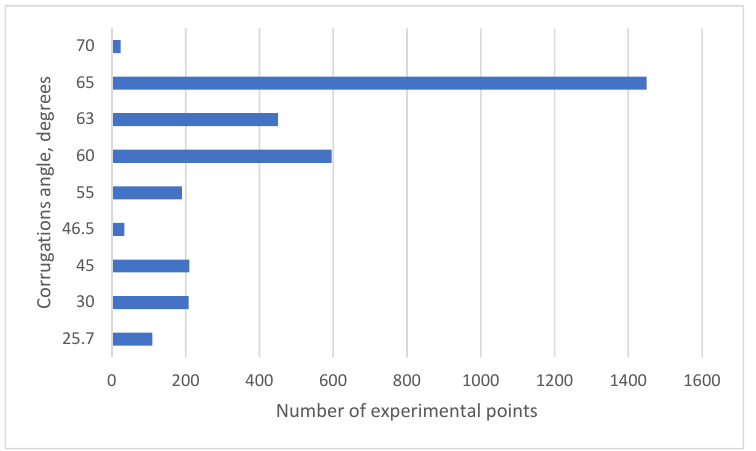
Figure 3. The number of experimental points data received in studies of PHEs with different angle of plates corrugation.